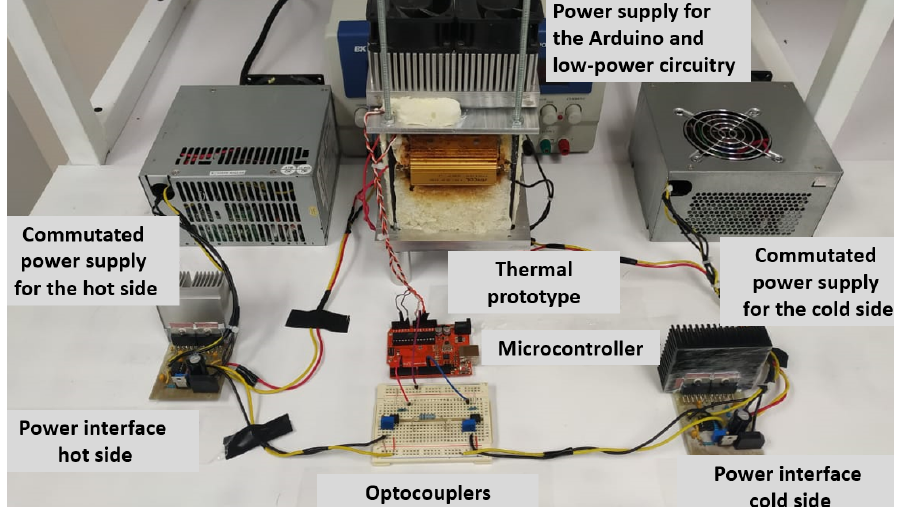
Figure 5. Complete implemented